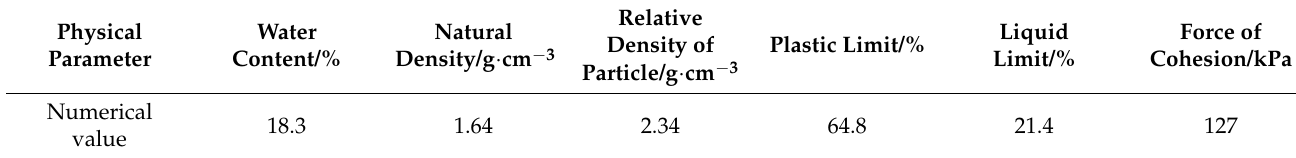
Table 6. Physical parameters of stone